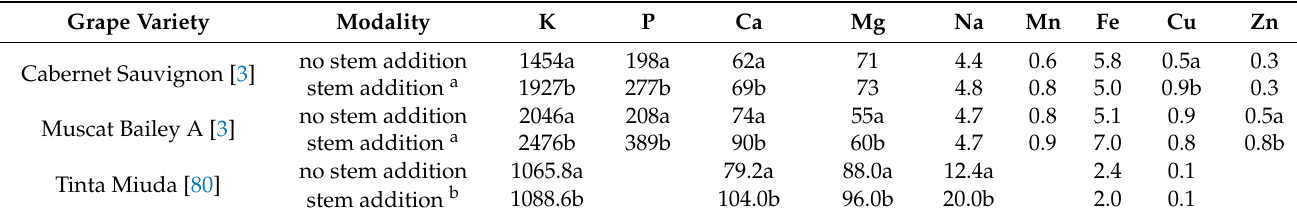
Table 13. Mineral composition of wines made with and without stem addition (mg/L) (for each study, different letters indicate significant statistical